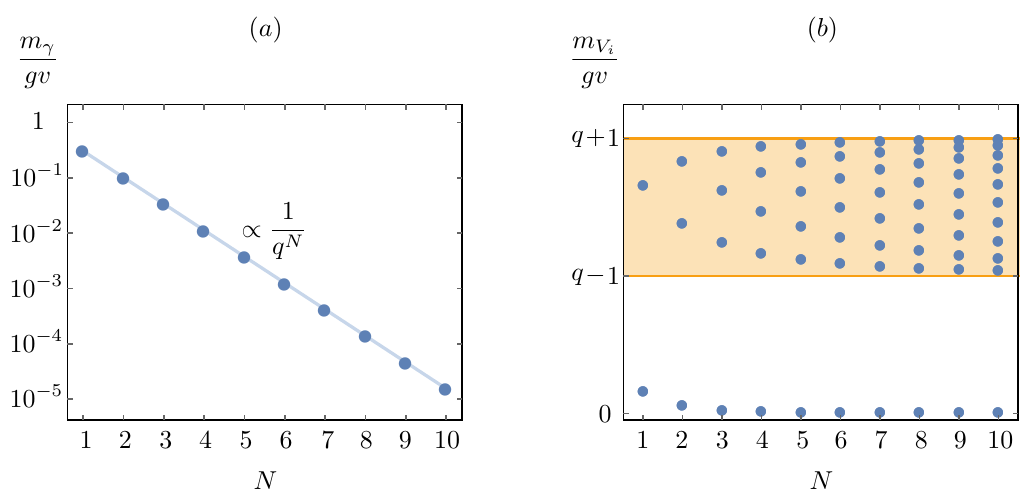
Figure 3 . Typical mass spectrum of the broken clockwork constructions discussed here. ( a ) Mass of the lightest vector as a function of N . ( b ) Masses of the N heavier vector modes. As in the standard (unbroken) clockwork model, their masses range from approximately ( q (orange band). In both (cid:12)gures, q = 3 for illustration.